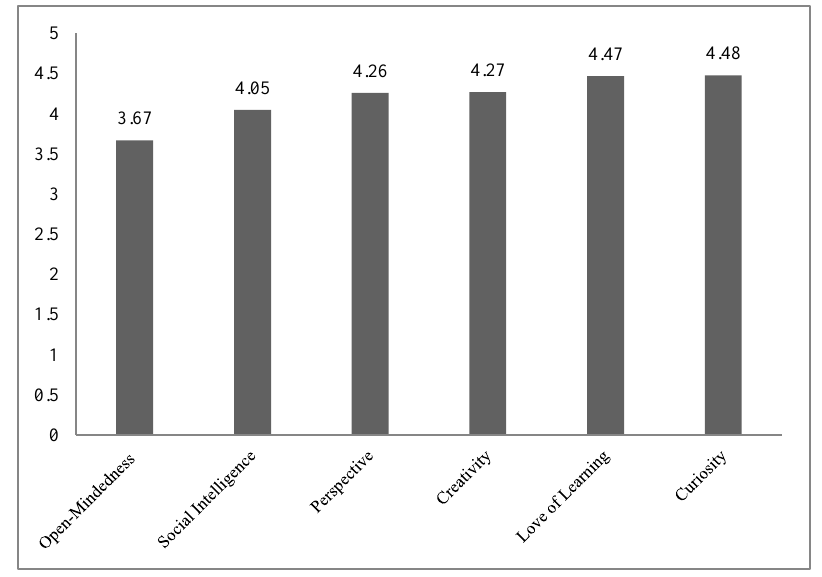
Fig. 2. 1st virtue: Wisdom and Knowledge (means, rated on a 5-point scale,